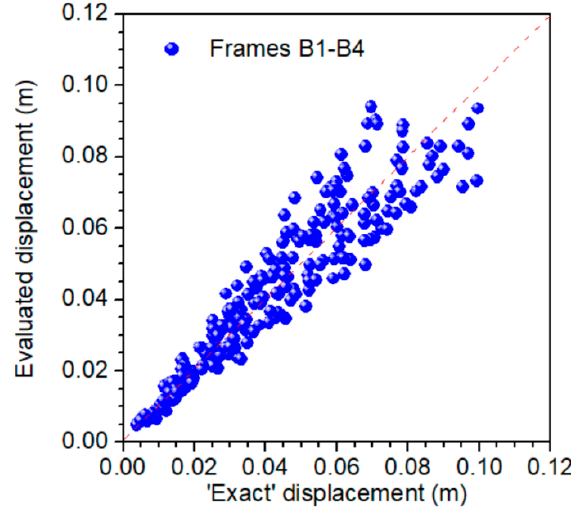
Figure 11. Evaluation of maximum displacements for poor-designed frames—Results from 224 dynamic inelastic analyses.